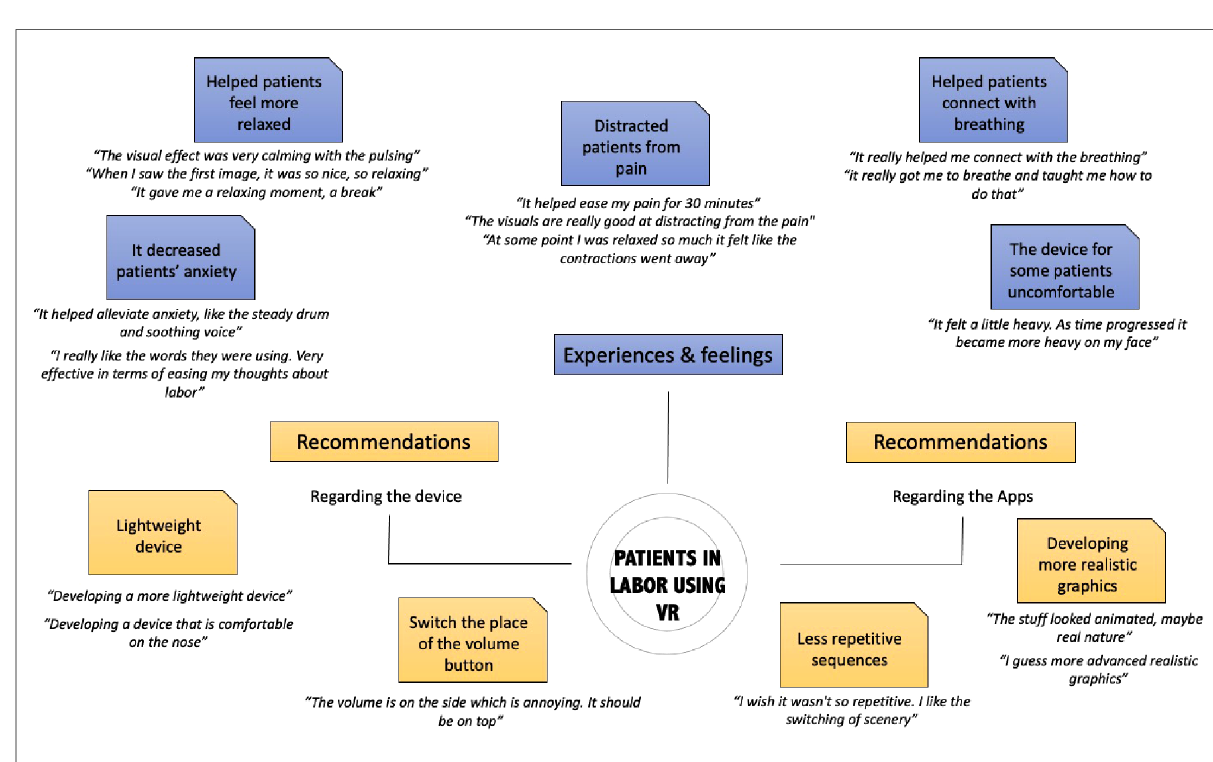
FIGURE 3 Qualitative mind map from guided interviews of pregnant persons who underwent VR in